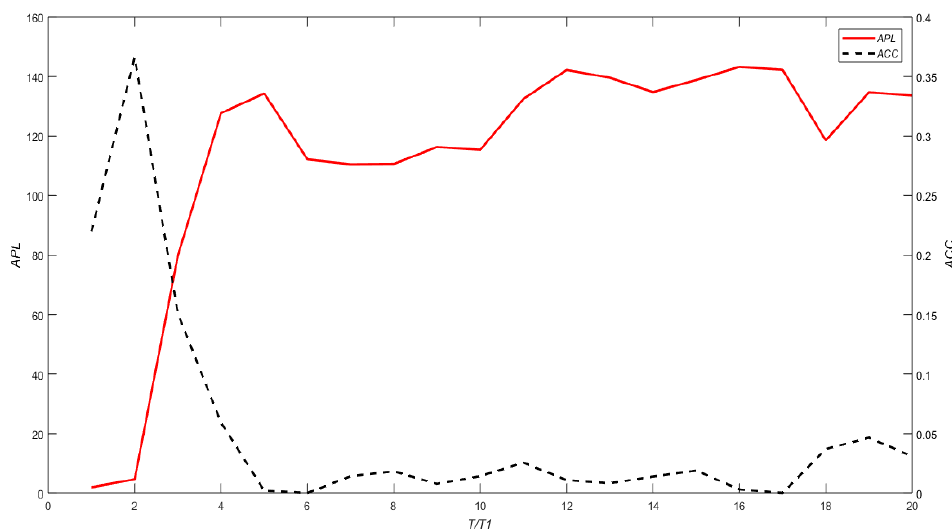
Figure 3. Evolution of APL and ACC in a collaborative innovation network.